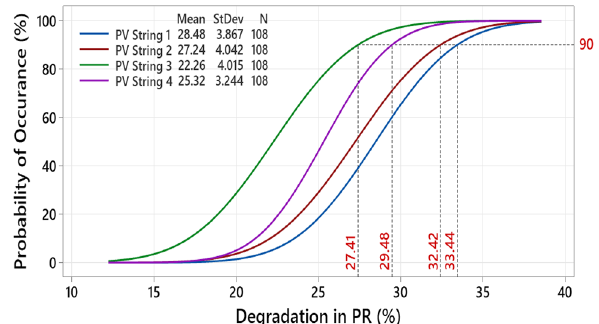
Figure 8. Plot of probability distribution functions for PV strings affected by PID. Probability of occurrence (in percentage) is represented by the y-axis, and degradation (in percentage) is represented by the x-axis. Plotting this figure requires data from Figs. 7b,c. N stands for the number of samples, and StDev for the standard